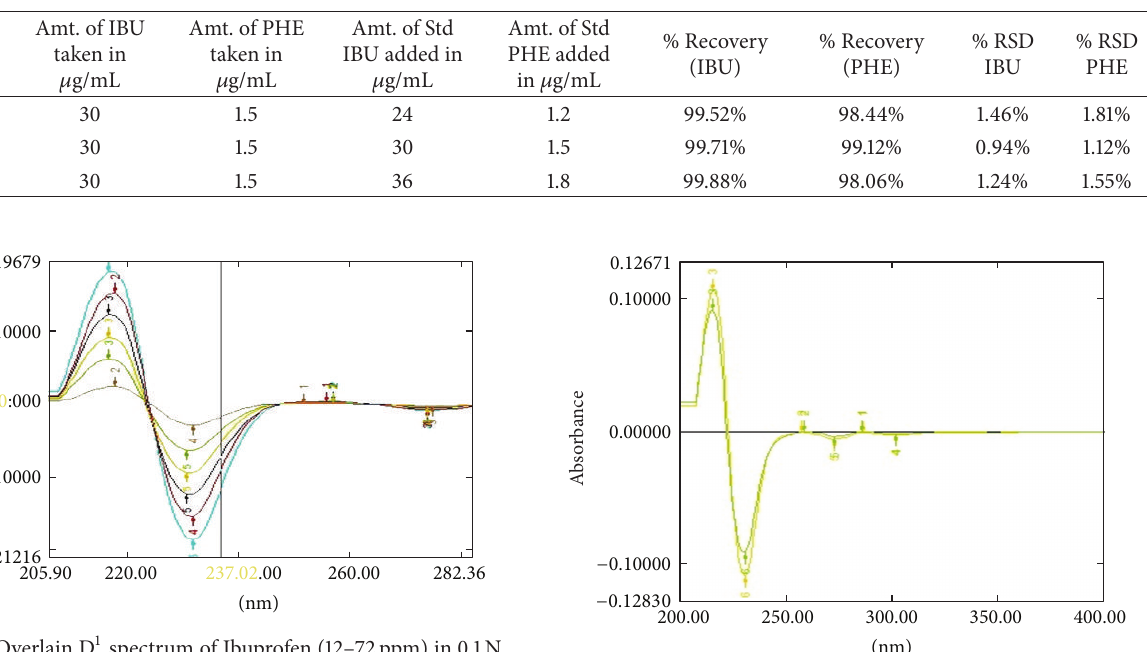
Figure 5: Overlain D 1 spectrum of Ibuprofen (12–72 ppm) in 0.1 N NaOH.